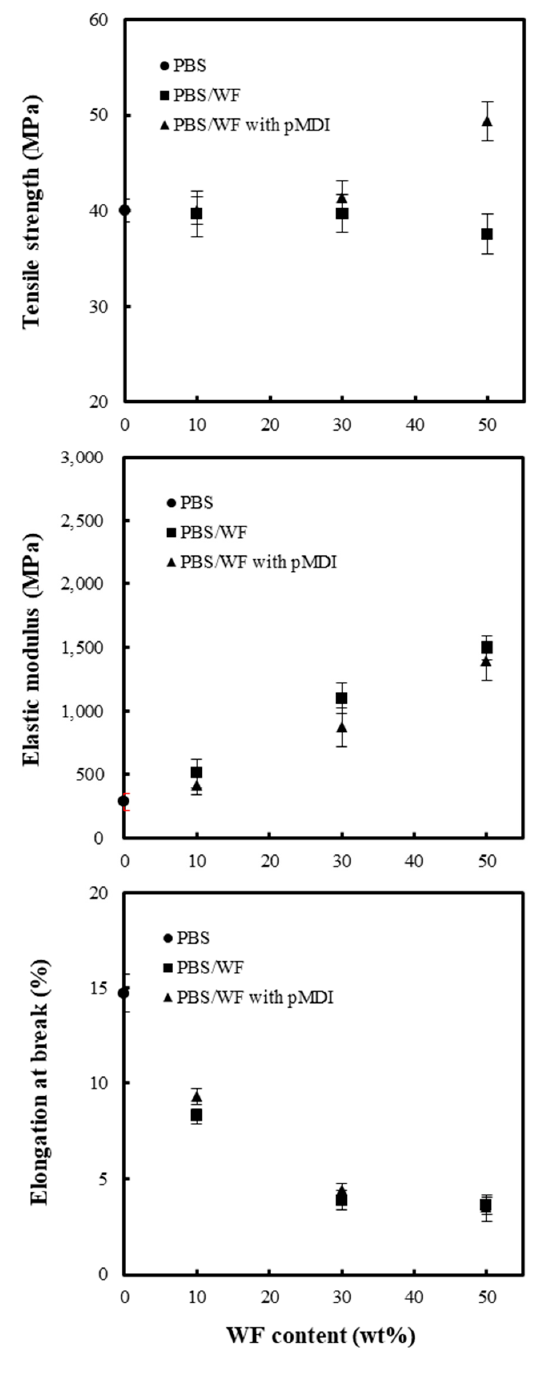
Figure 4. Tensile strength, elastic modulus, and elongation at break of PBS / WF composites with and without pMDI (2phr).